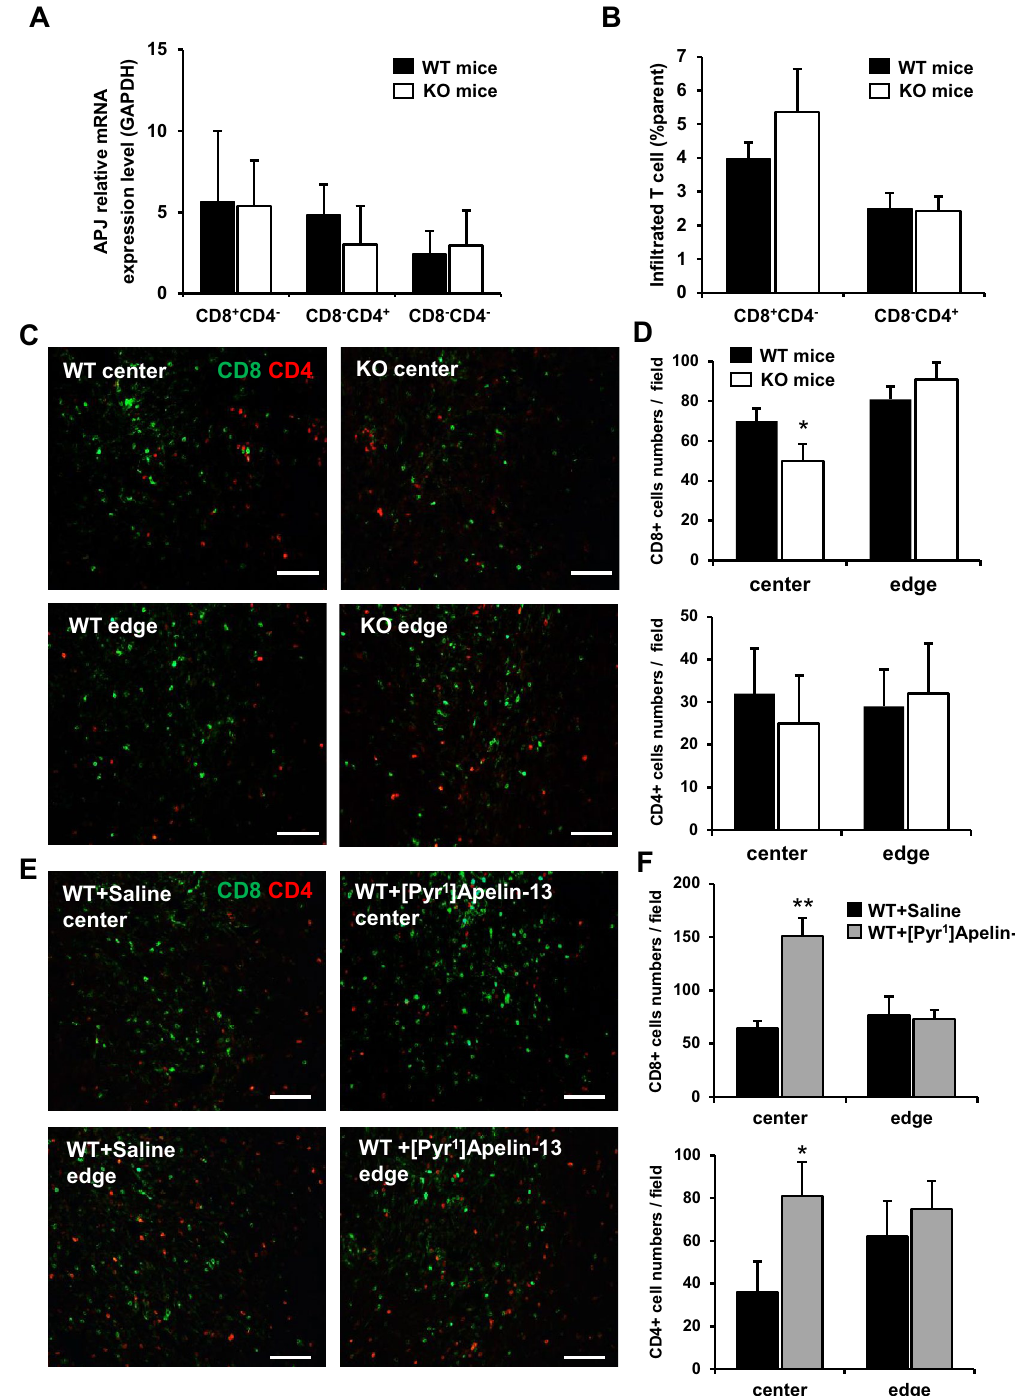
Figure 4. CD8 + and CD4 + T cell infiltration and accumulation in tumors. ( A ) APJ expression by qRT-PCR. CD8 + and CD4 + T cells were isolated from WT and Apelin-KO mice bearing tumors at day19 by flow cytometry. APJ expression levels were normalized to GAPDH. ( B ) Flow cytometric analysis of total infiltrated CD8 + and CD4 + T cells. Cell numbers are presented as percentages of total living cells (n = 6 for each group). ( C ) Immunofluorescence staining of CD8 (green) and CD4 (red) in the frozen sections of MC38 tumors from WT or Apelin-KO mice. Tumor samples were collected at day 19. Scale bar = 100 µm. ( D ) Quantitative evaluation of the number of infiltrated CD8 + and CD4 + T cells in MC38 tumors (6 random fields of 5 independent tumor sections). ( E ) Immunofluorescence staining of CD8 (green) and CD4 (red) in the frozen sections of MC38 tumors from WT mice infused with [Pyr 1 ]Apelin-13 or saline using osmotic pumps. Tumor samples were collected at day 19. Scale bar = 100 µm. ( F ) Quantitative evaluation of the number of infiltrated CD8 + and CD4 + T cells in MC38 tumors (6 random fields of 5 independent tumor sections). The error bars indicate mean ± SD and all data were analyzed by two-sided Student’s t-test. *p < 0.05, **p <